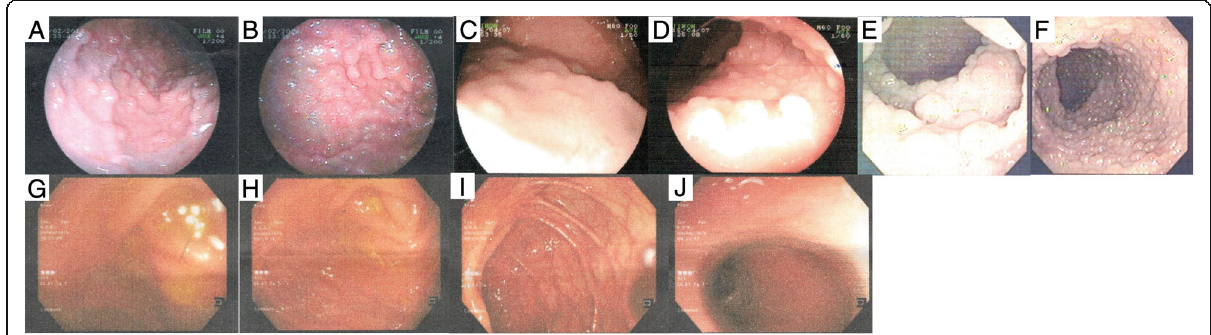
Fig. 2 Colonoscopy analysis of affected and unaffected members. a-f Familial adenomatous polyp: multiple polyps in the colon of affected